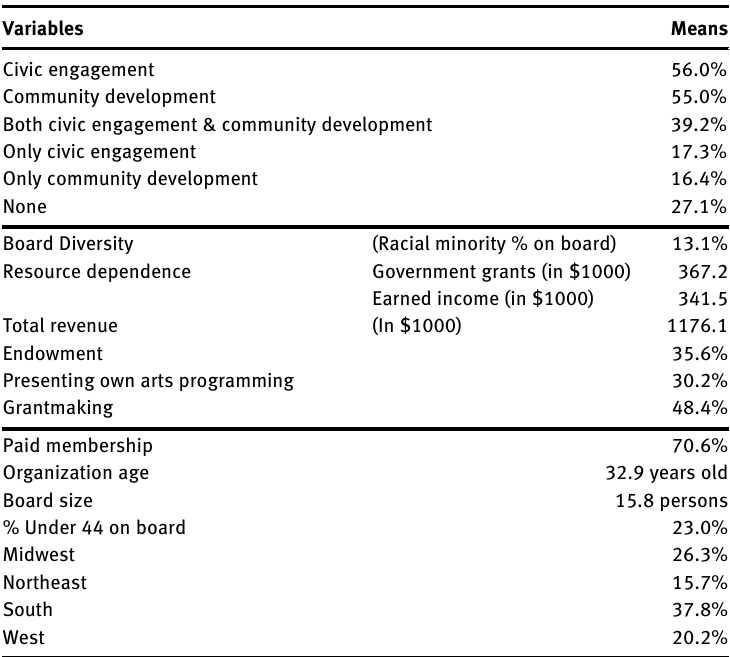
Table  : Descriptive statistics ( N = 